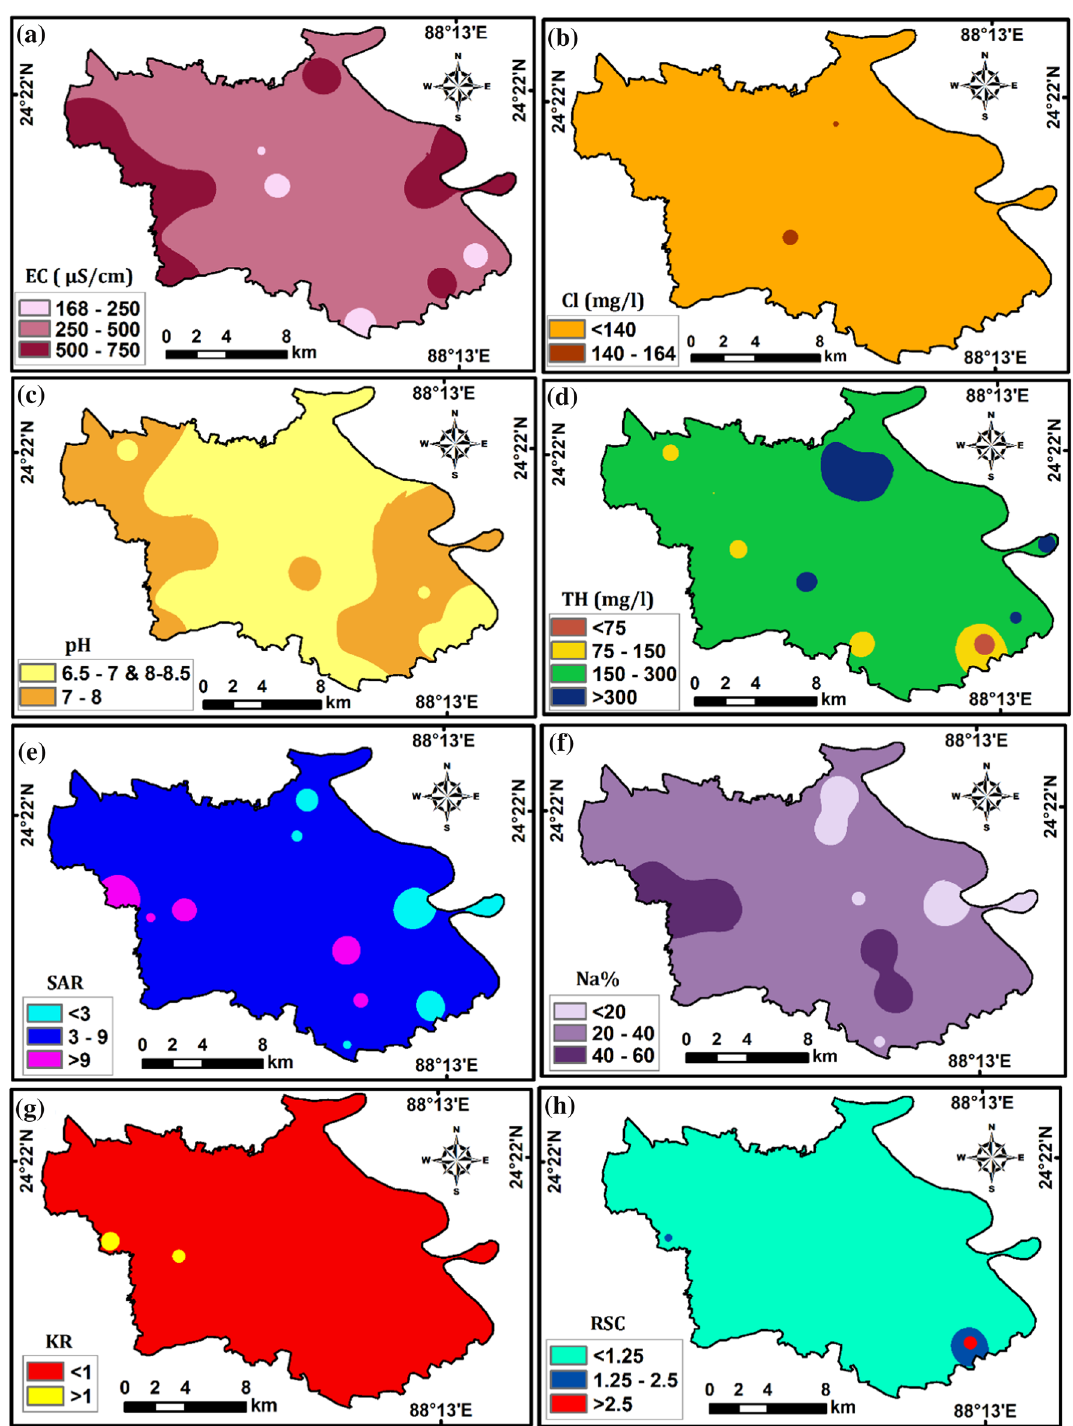
Fig. 4 Spatial distribution maps of irrigation water quality evaluation indices in the study area; a EC; b Cl; c pH; d TH; e SAR; f Na%; g KR; h